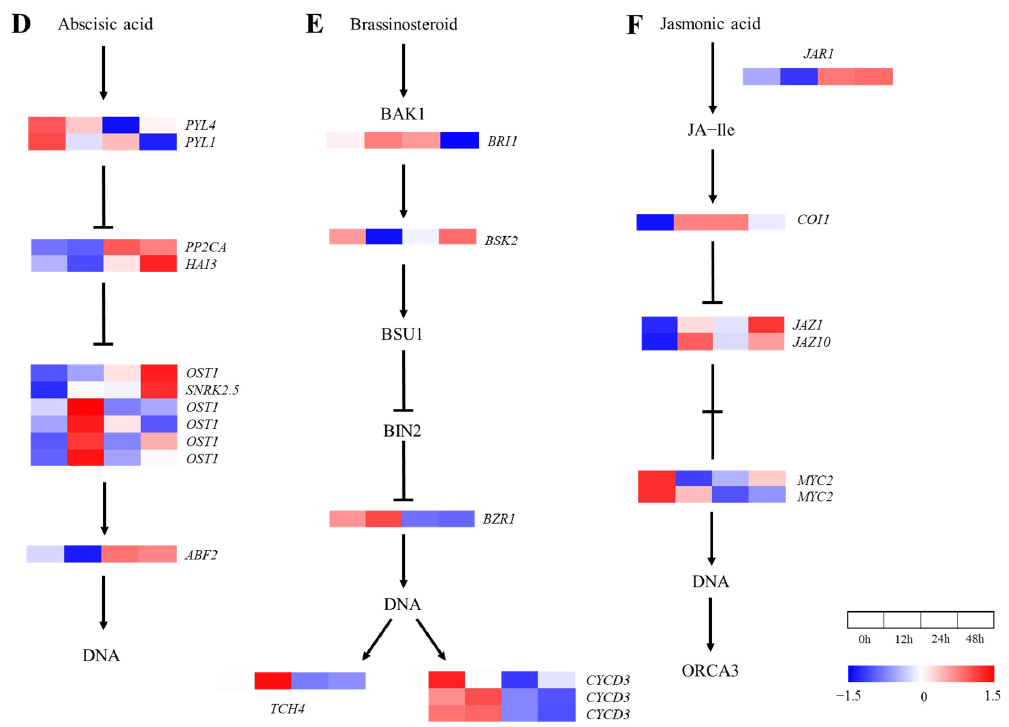
Figure 7. Heat map of annotated genes in plant hormone signal transduction pathway. Solid lines and arrows indicate the signal transduction process and direction. ( A ) Indole-3-acetic acid (IAA) signaling pathway; ( B ) cytokinin (CK) signaling pathway; ( C ) gibberellin (GA) signaling pathway; ( D ) abscisic acid (ABA) signaling pathway; ( E ) brassinolide (BR) signaling pathway; ( F ) jasmonic acid (JA) signaling pathway.